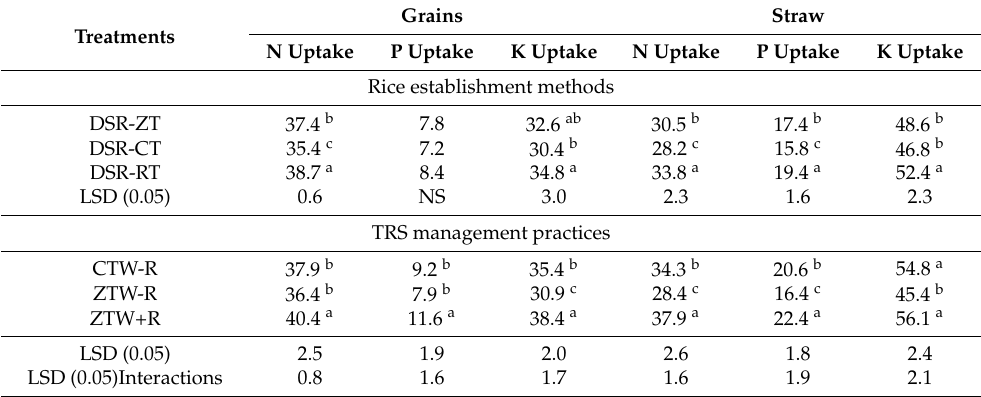
Table 3. Removal of macronutrients (kg ha − 1 ) by rice grains and straw under different rice establish- ment methods. Grains Straw Treatments N Uptake P Uptake K Uptake N Uptake P Uptake K Uptake Rice establishment